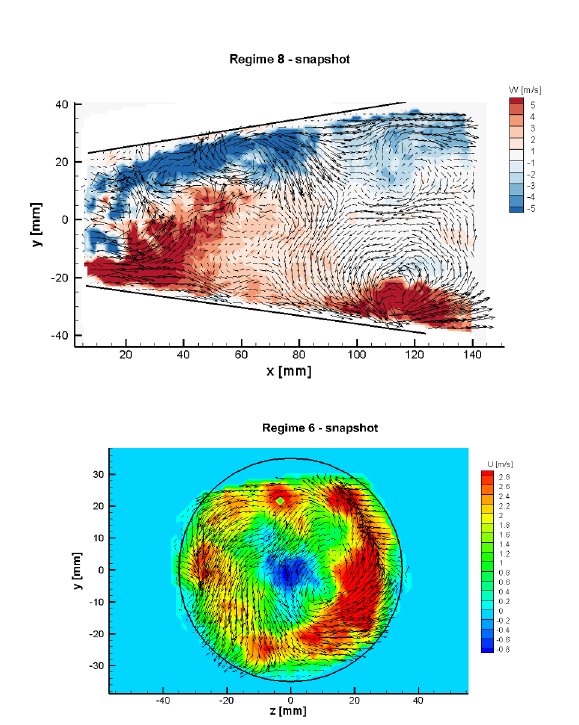
Fig. 4a, b. Instantaneous flow fields, longitudinal (a) and cross- sectional (b) planes .